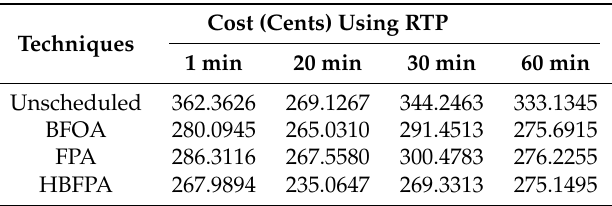
Table 6. Electricity cost for 24 h (For single